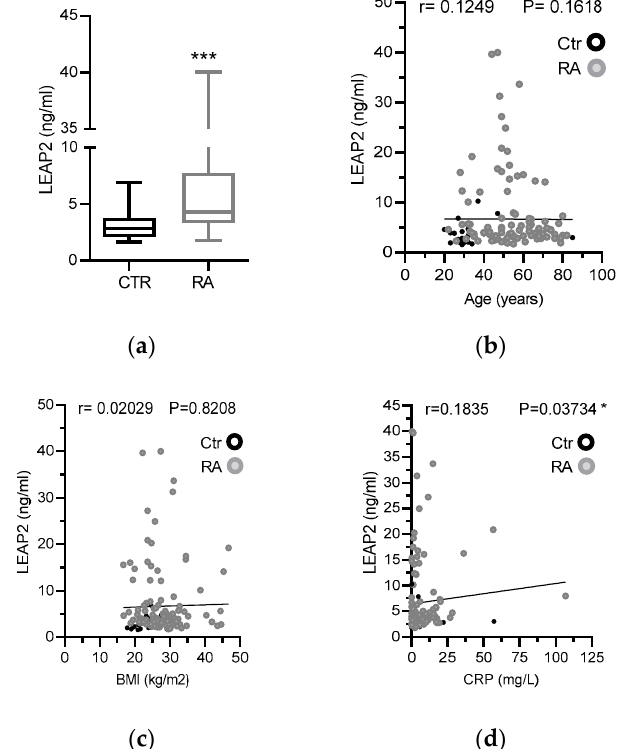
Figure 1. Comparative analysis of Liver-expressed antimicrobial peptide 1 (LEAP2) serum levels in rheumatoid arthritis (RA) patients and healthy controls. ( a ) Plasma levels of LEAP2 protein (ng / mL) were measured by ELISA as described in methods. Data were presented using a vertical box and whiskers graph and compared using the Wilcoxon–Mann–Whitney test. ( b ) Relationship between LEAP2 serum levels and age (years), ( c ) BMI (kg / m 2 ) or ( d ) CRP serum levels (mg / L). Data were analyzed by Spearman’s correlation test (r). *** p <